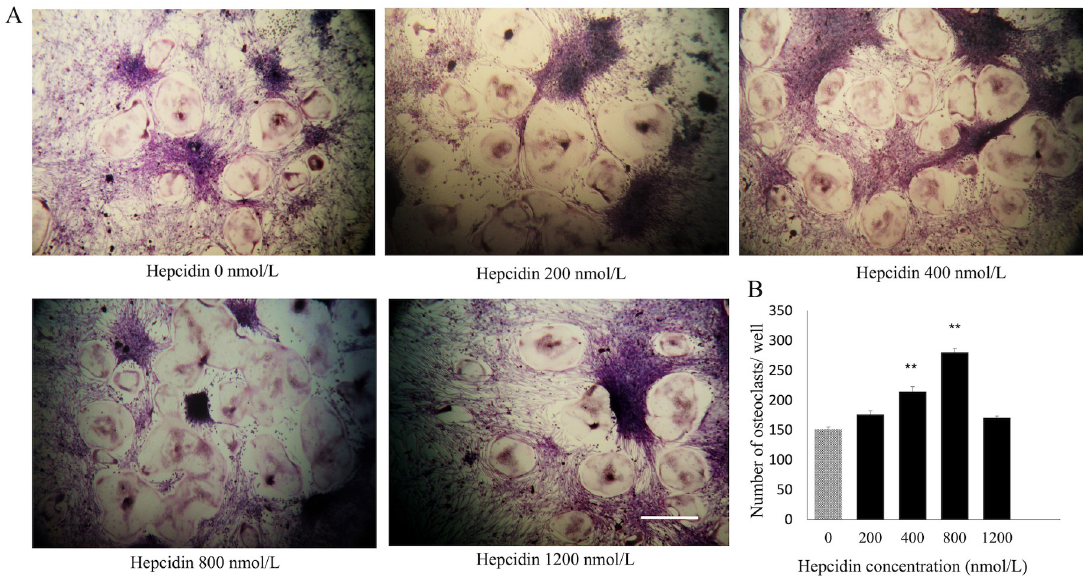
Fig 1. Shows effect of hepcidin 1 on canine OC differentiation. (A) The cells were treated with various concentrations of hepcidin followed by M-CSF (20 ng/mL) and RANKL (50 ng/mL) for 7 days. The cells were stained for TRAP stain and TRAP-positive cells ( � 3 nuclei) were counted. Scale bar- 200 μ m. (B) Bar graphs show the number of OC cells/well. Data are representative of three independent experiments and expressed as means ± SE. Means with � are significantly different from 0 μ g/mL of hepcidin ( � p < 0.05, �� p < 0.01).